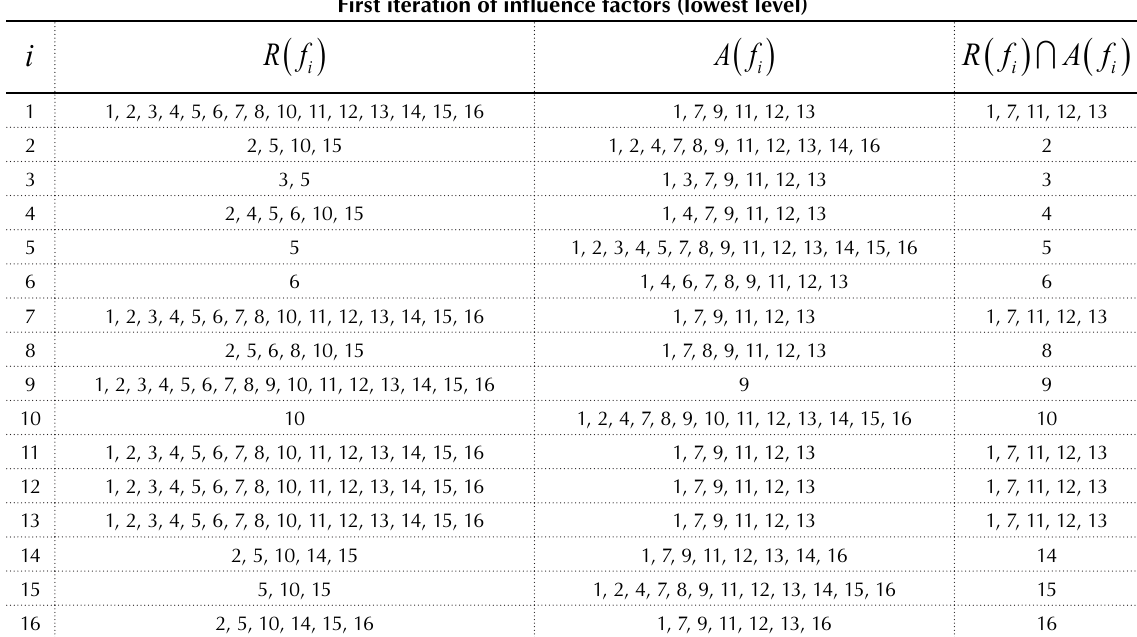
Table 2. Sequence of iterations determining the hierarchy levels of factors influencing the energy security of the